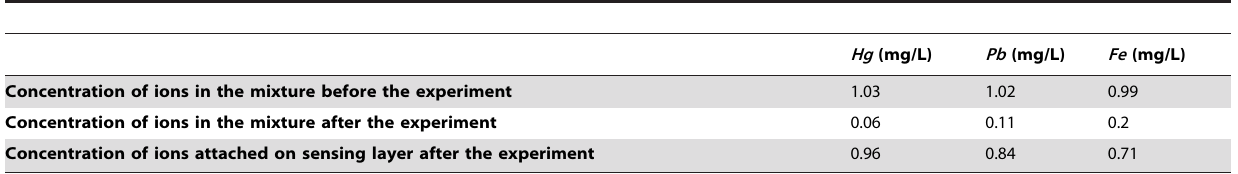
Table 3. The concentration of ions in the mixture and attached the sensing layer were measured using ICP-MS before and after the